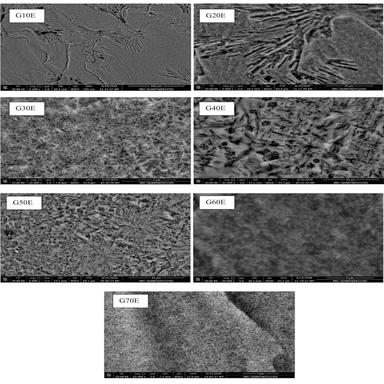
SEM of the investigated after heat- treatment at 550◦C, 2h then at 800◦C, 2h.